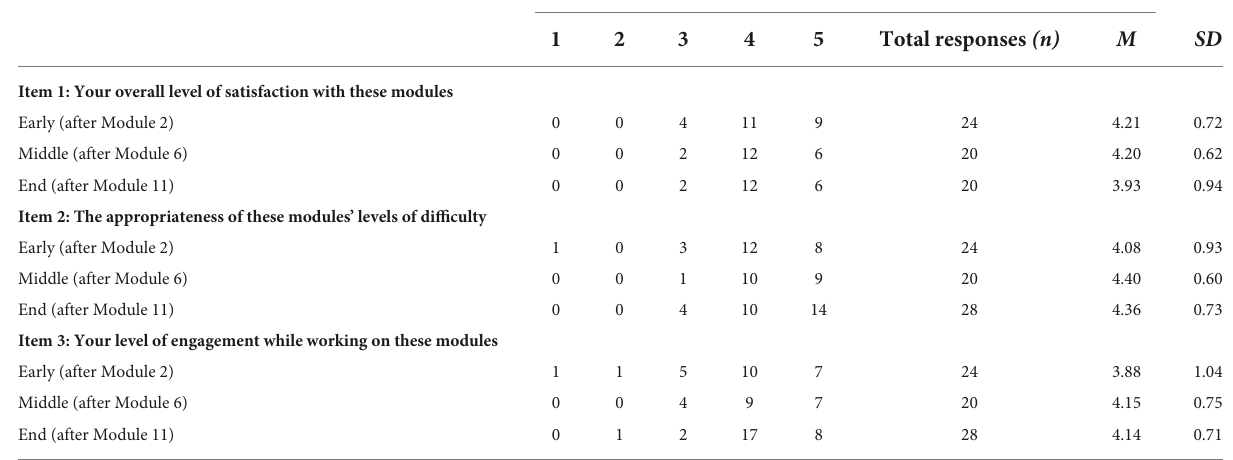
TABLE 9 Teacher ratings of modules: Satisfaction, difficulty, and